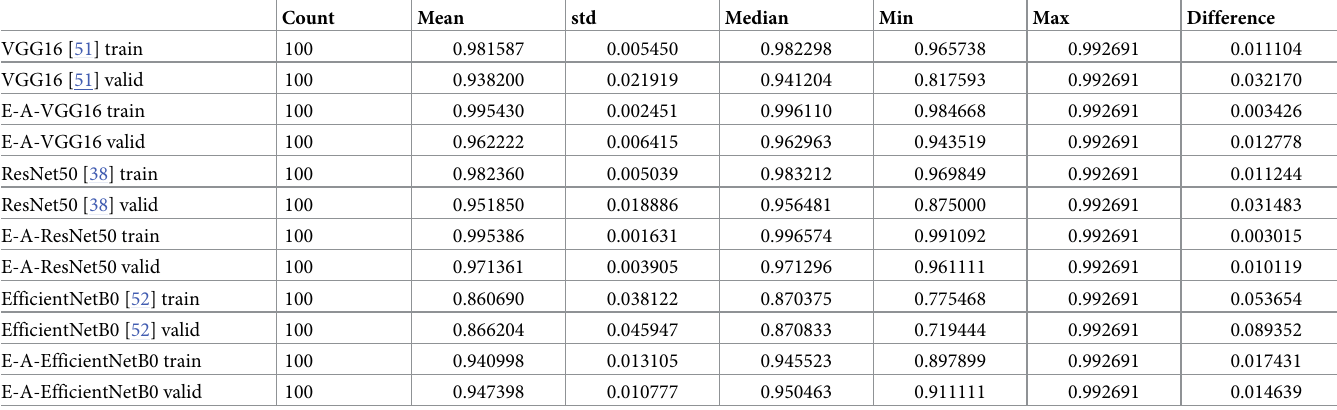
Table 3. Train and validation results